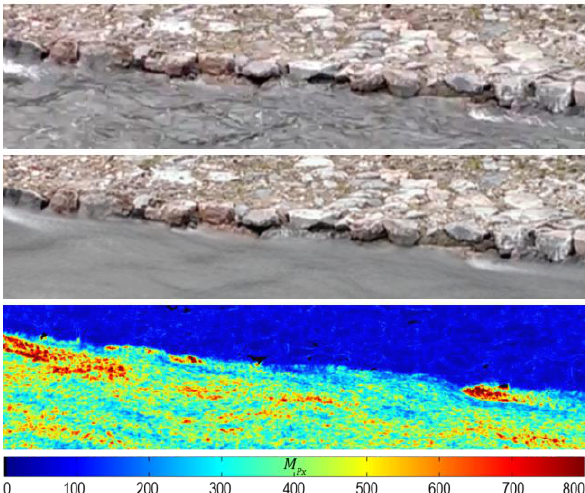
Figure 4. Detail view of a co-registered time lapse image sequence taken with 3 fps over 5 s in study area (I). Top down: master image, associated average image & spatio-temporal texture visualized by observed pixel magnitudes 𝑀 𝑃𝑥